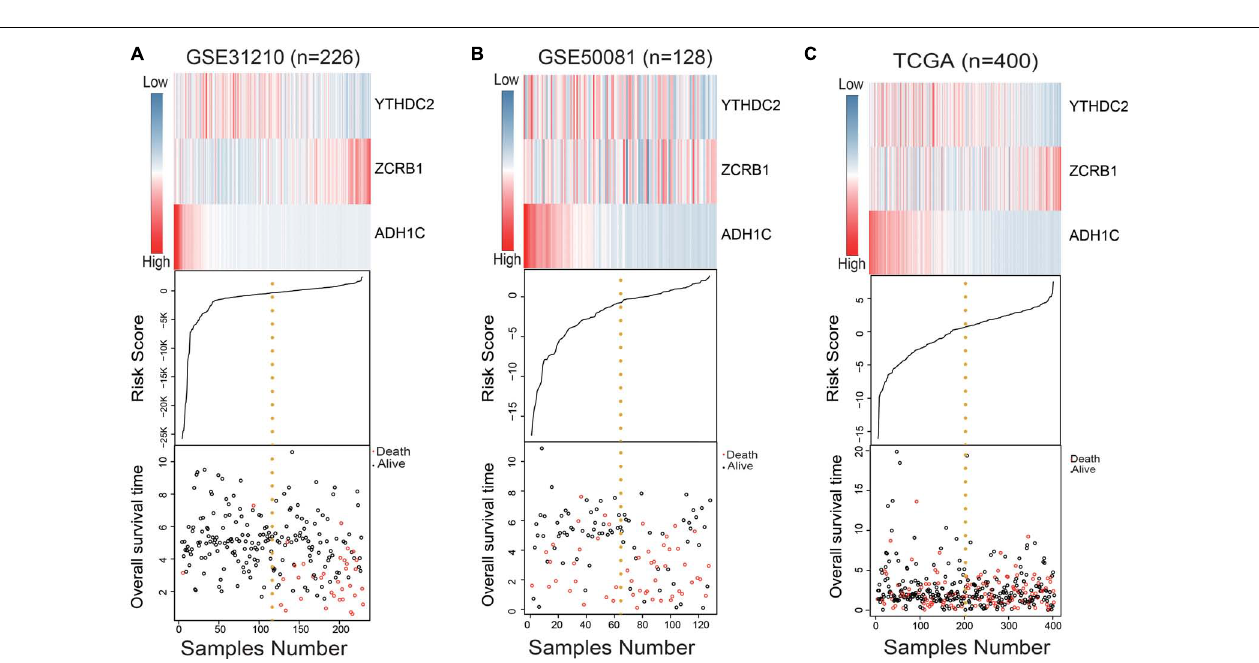
FIGURE 2 | Evaluation of the risk predictive model in the training set and test set. (A–C) The distribution of m 6 A RNA methylation regulators and m 6 A-related gene expression level, patients’ survival status, and risk score between high- and low-risk group.